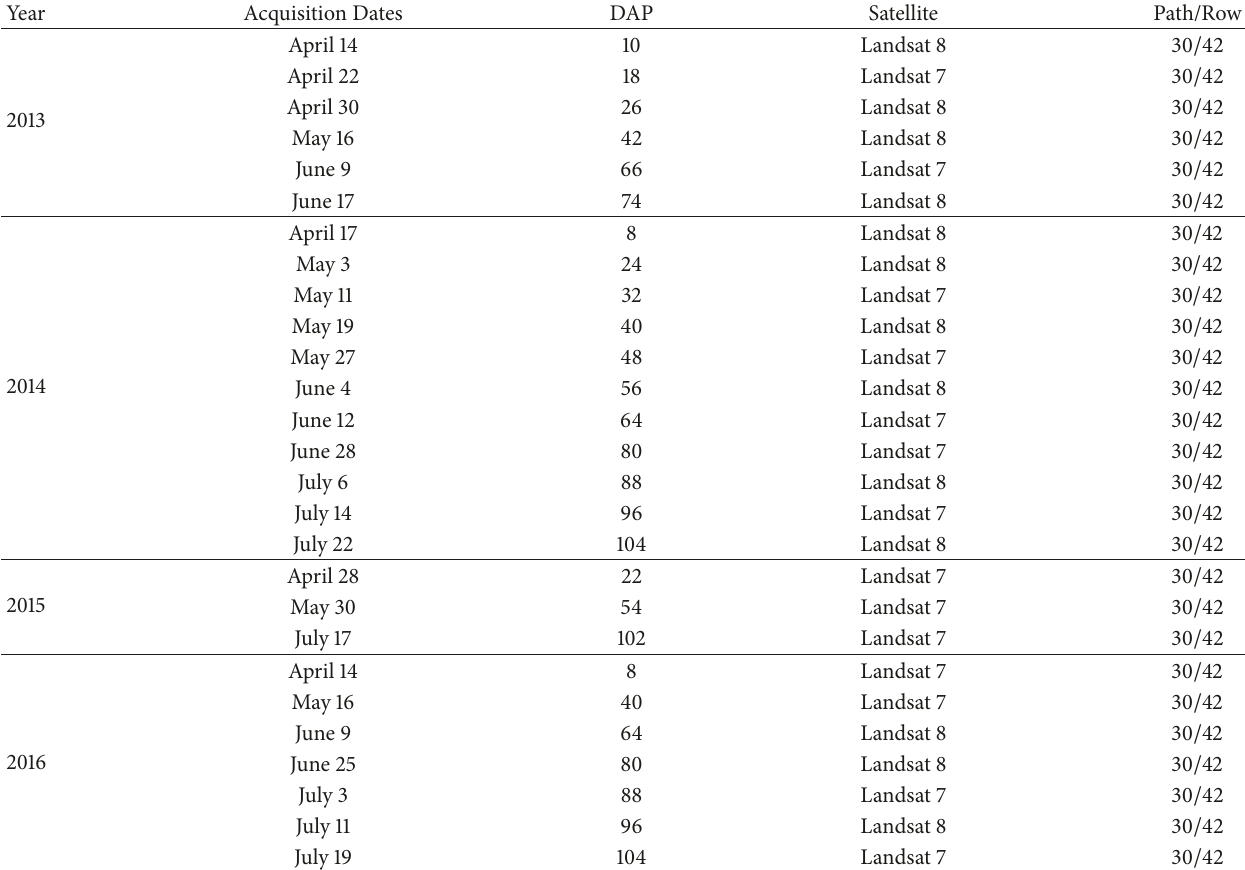
Table 1: The year, acquisition dates, day after planting (DAP), Landsat satellite, and path/row for 2013, 2014, 2015, and 2016 growing seasons.